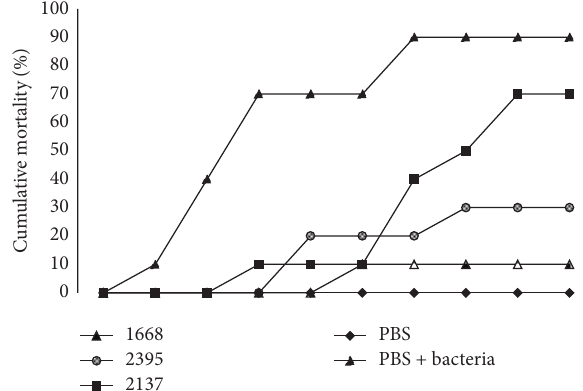
Figure 5: Cumulative percent mortalities of fish injected intraperi- toneally (i.p) with 100 𝜇 L PBS alone, PBS alone with bacterial challenge, CpG ODN 1668, 2395, and control ODN 2137. After 48 h after CpG ODN injection, cobia was i.p. injected with 50 𝜇 L of 3.25 × 10 6 bacteria ( Photobacterium damselae subsp. piscicida ). The group injected with ODN 2395 and 1668 displayed lower mortalities than any other group, 𝑛 = 10 fish per